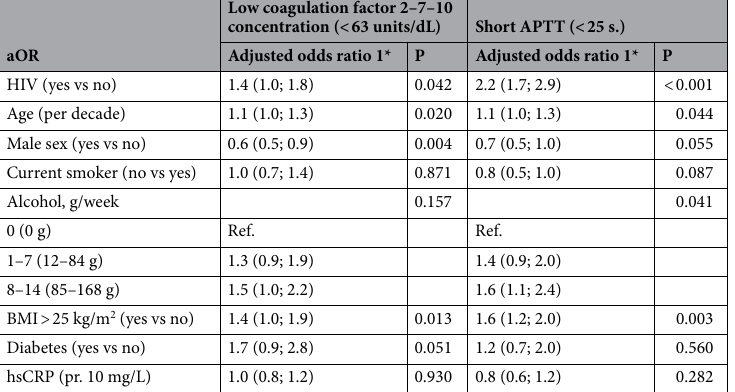
Table 2. Multivariable logistic regression analyses. HIV human immunodeficiency virus, BMI Body Mass Index, hsCRP High sensitivity C-reactive protein. *Adjusted for age, sex, smoking status, alcohol use, BMI, diabetes and